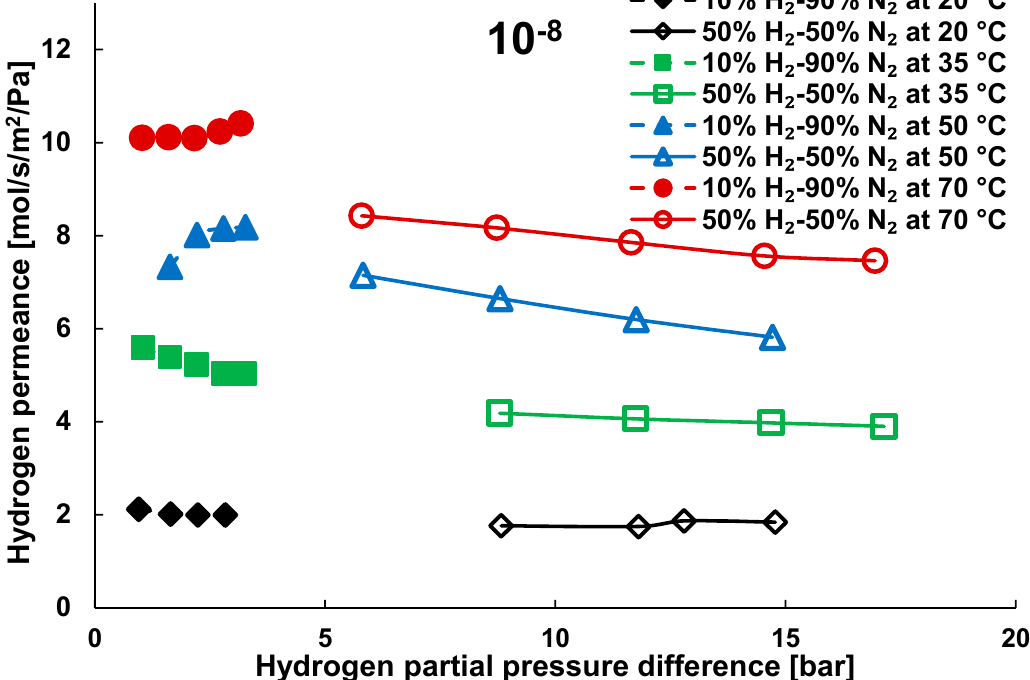
Figure 11. Comparison between hydrogen flow rate in an H 2 -N 2 mixture with 10% and 50% hydrogen concentration at 20, 35, 50 and 70 °C, for CMSM-550.